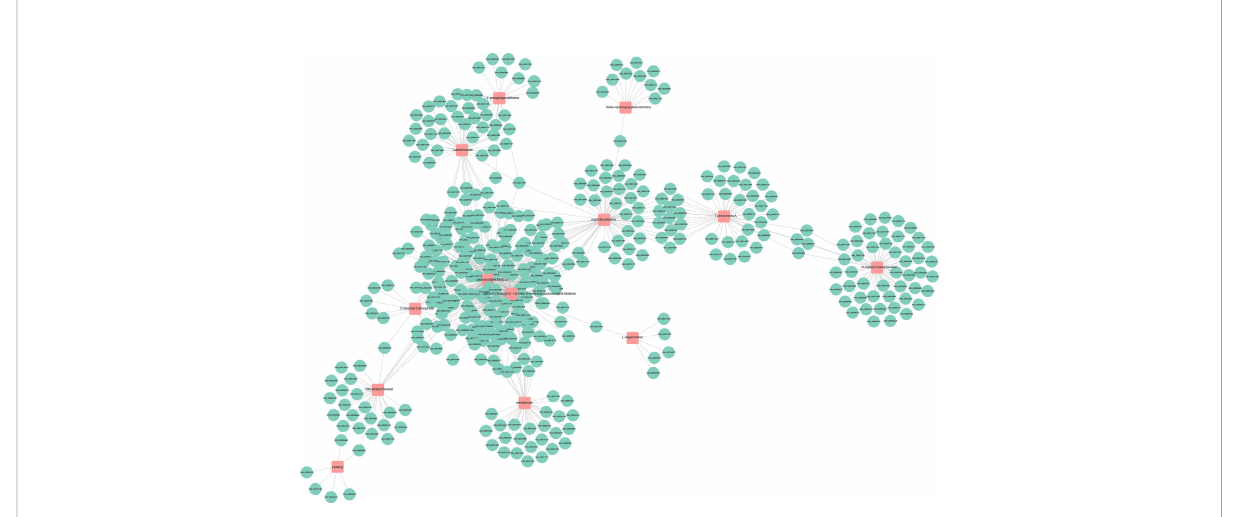
FIGURE 12 Connection network between differentially expressed genes (green circles) and differential accumulated metabolites (red